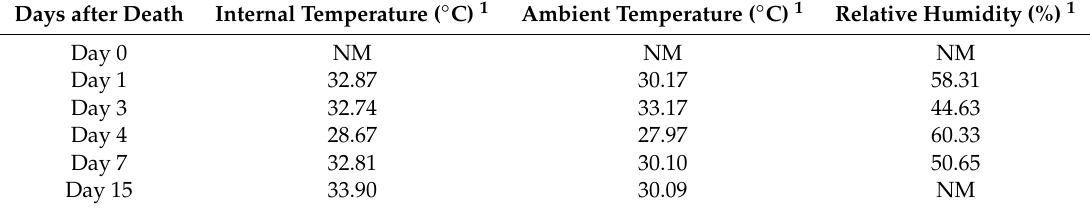
Figure 1. Carcasses of common kestrel ( Falco tinnunculus ) in the prone position with temperature / humidity probes. Table 1. Weather conditions during the experiment in common kestrel ( Falco tinnunculus ). Days after death, internal carcass temperature, ambient temperature and humidity during the experiment are provided(4–19July2019, sunrise06:48–06:57a.m. andsunset09:31–09:26p.m., raining0mm, meanwind speed 9.16 km / h, Murcia,